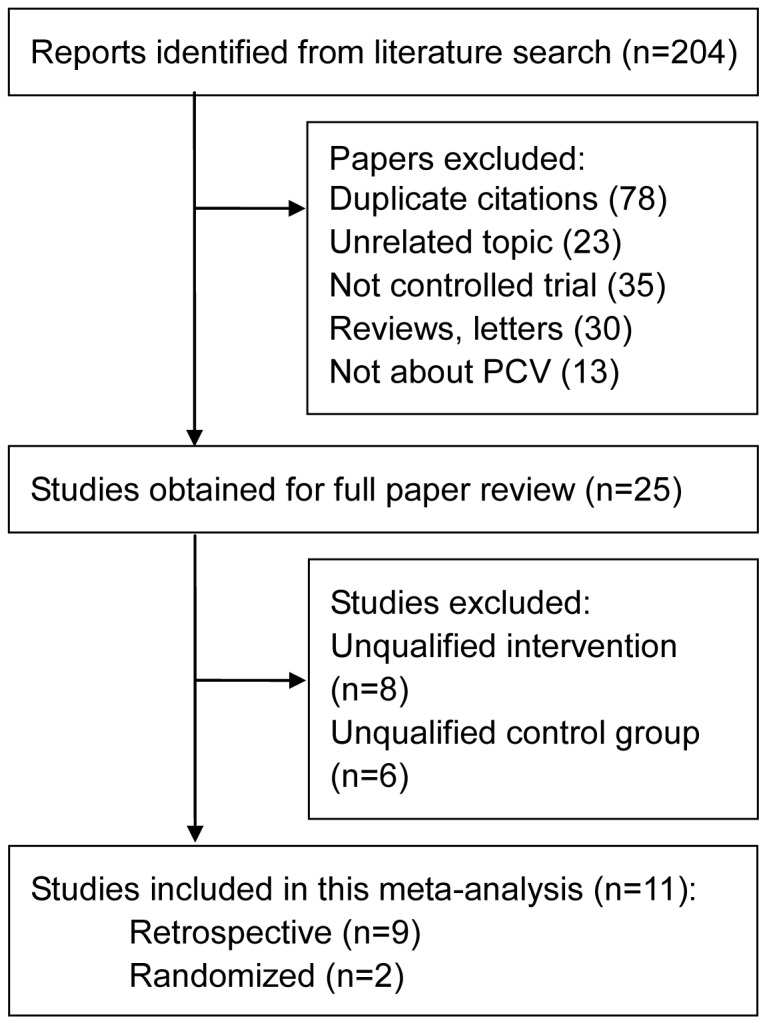
Flow diagram of included studies for this meta-analysis.